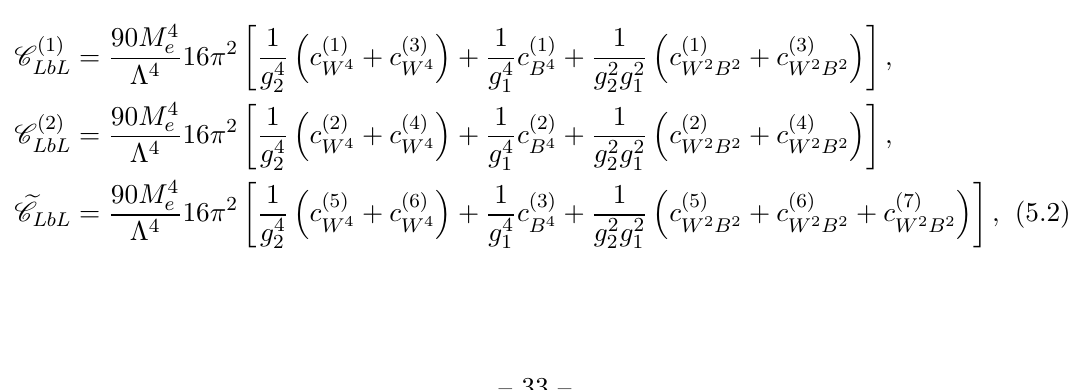
Table 17 . The dimension-eight operators in the SMEFT of class-20 whose (cid:12)eld content super(cid:12)cially includes a down-quark-type Yukawa interaction or is baryon number violating. All of the operators have Hermitian conjugates. The subscripts p; r; s; t are weak-eigenstate indices. On the other hand, for a less restrictive energy range, E (cid:28) (cid:3), the SMEFT Wilson coe(cid:14)cients from table 2 appearing in eq. (5.1)